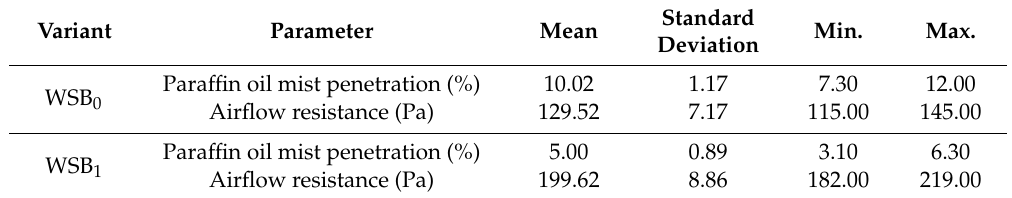
Standard Min. Deviation